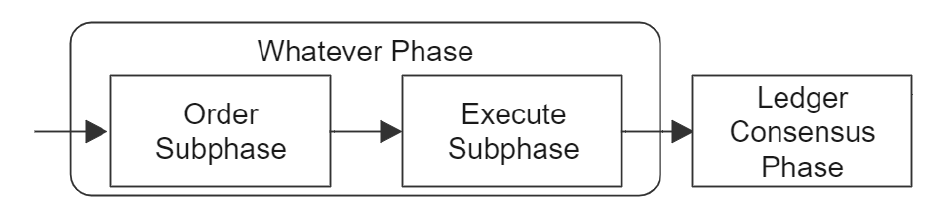
Figure 5. Whatever-Ledger Consensus transaction processing